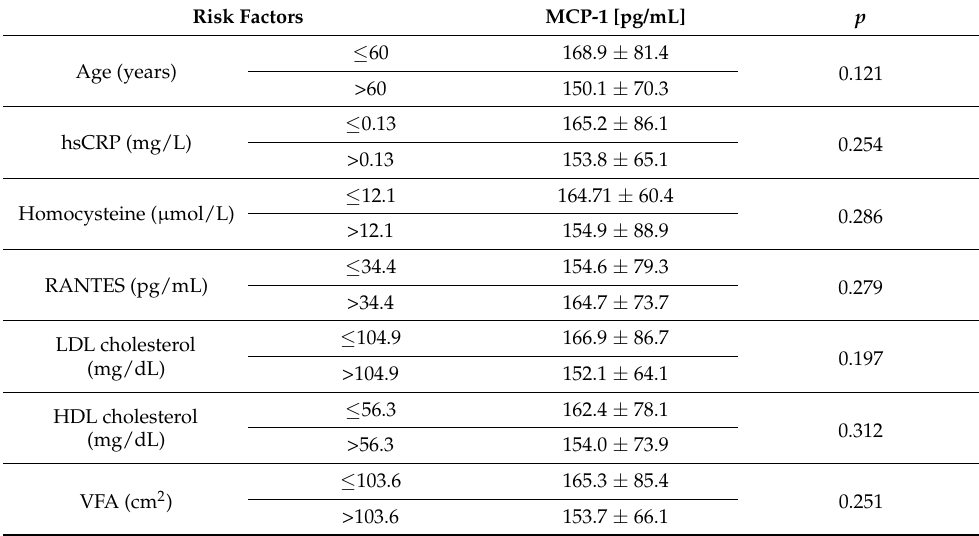
Table 4. Baseline mean MCP-1 plasma concentrations with respect to age and selected risk factors ( n = 79). p indicates differences between groups (independent samples t